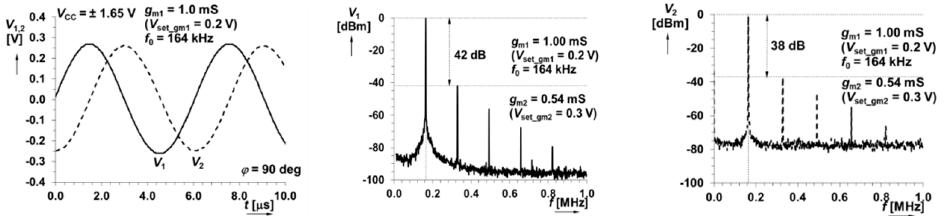
Figure 15. Experimental results for the oscillator: (left) output waveforms; (middle) spectral analysis of V 1 ; (right) spectral analysis of V 2 .